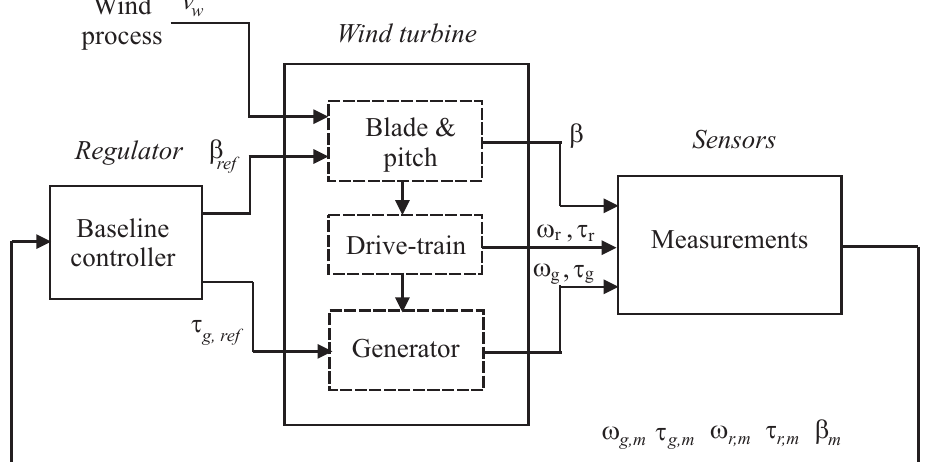
Figure 1. Scheme of the offshore wind turbine simulator.